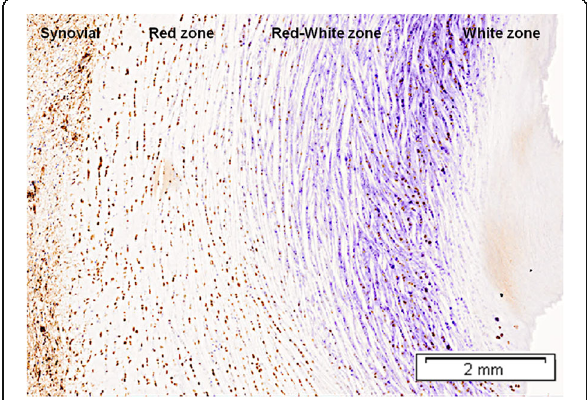
Fig. 2 Transversal section of the medial meniscus from a healthy rabbit knee immunostained for COMP. The extracellular matrix revealed the same heterogeneous distribution as for the cells, decreasing from the red to the white